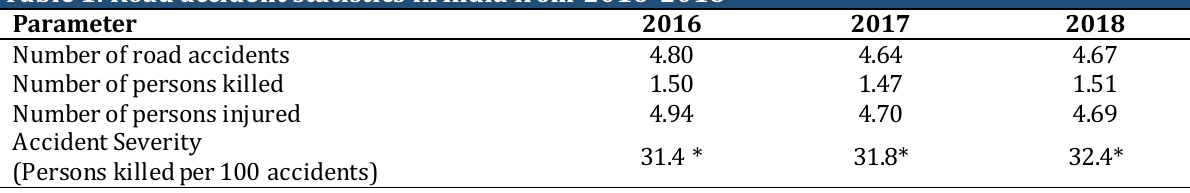
Table 1: Road accident statistics in India from 2016-2018